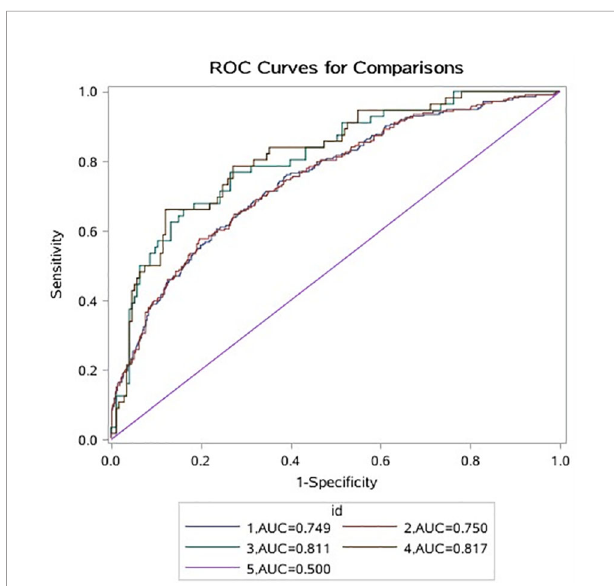
FIGURE 3 | 1 indicates that A data do not contain the ROC curve corresponding to leu; 2 indicates that A data contain the ROC curve corresponding to leu; 3 indicates that B data do not contain the ROC curve corresponding to leu; 4 means that B data contain ROC curve corresponding to leu; 5 represents ROC invalid curve. ROC, receiver operating